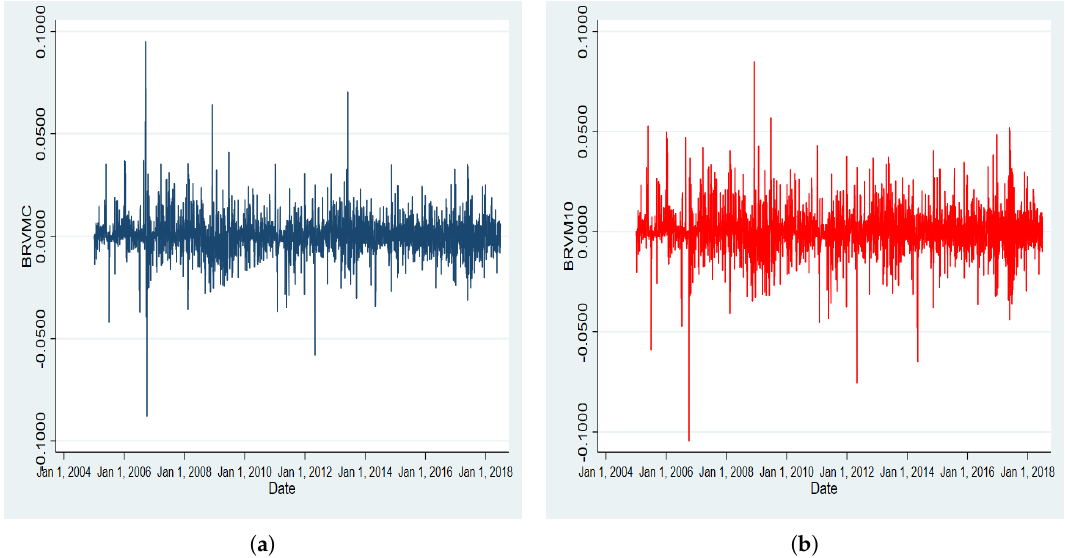
Figure A2. Dynamics of the returns for the BRVMC and BRVM10. ( a ) Dynamics of the BRVMC returns; ( b ) Dynamics of the BRVM10 returns.